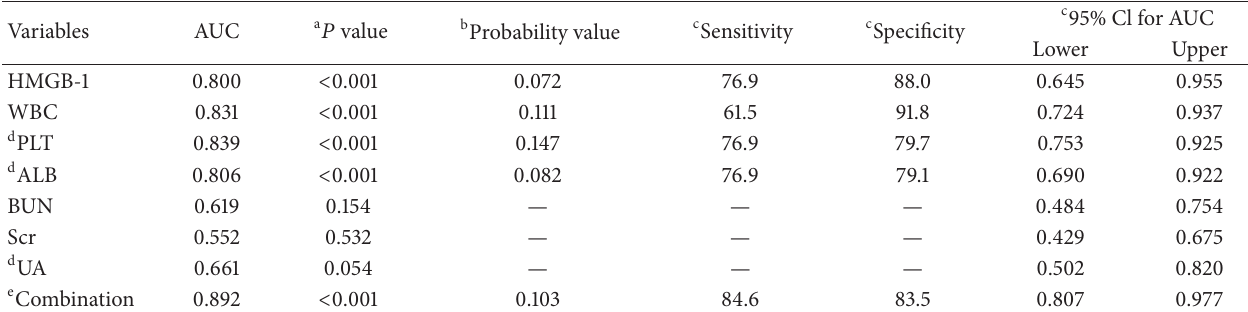
Table 5: Predictive values for prognosis with HMGB-1 and laboratory parameters in patients with HFRS. Variables